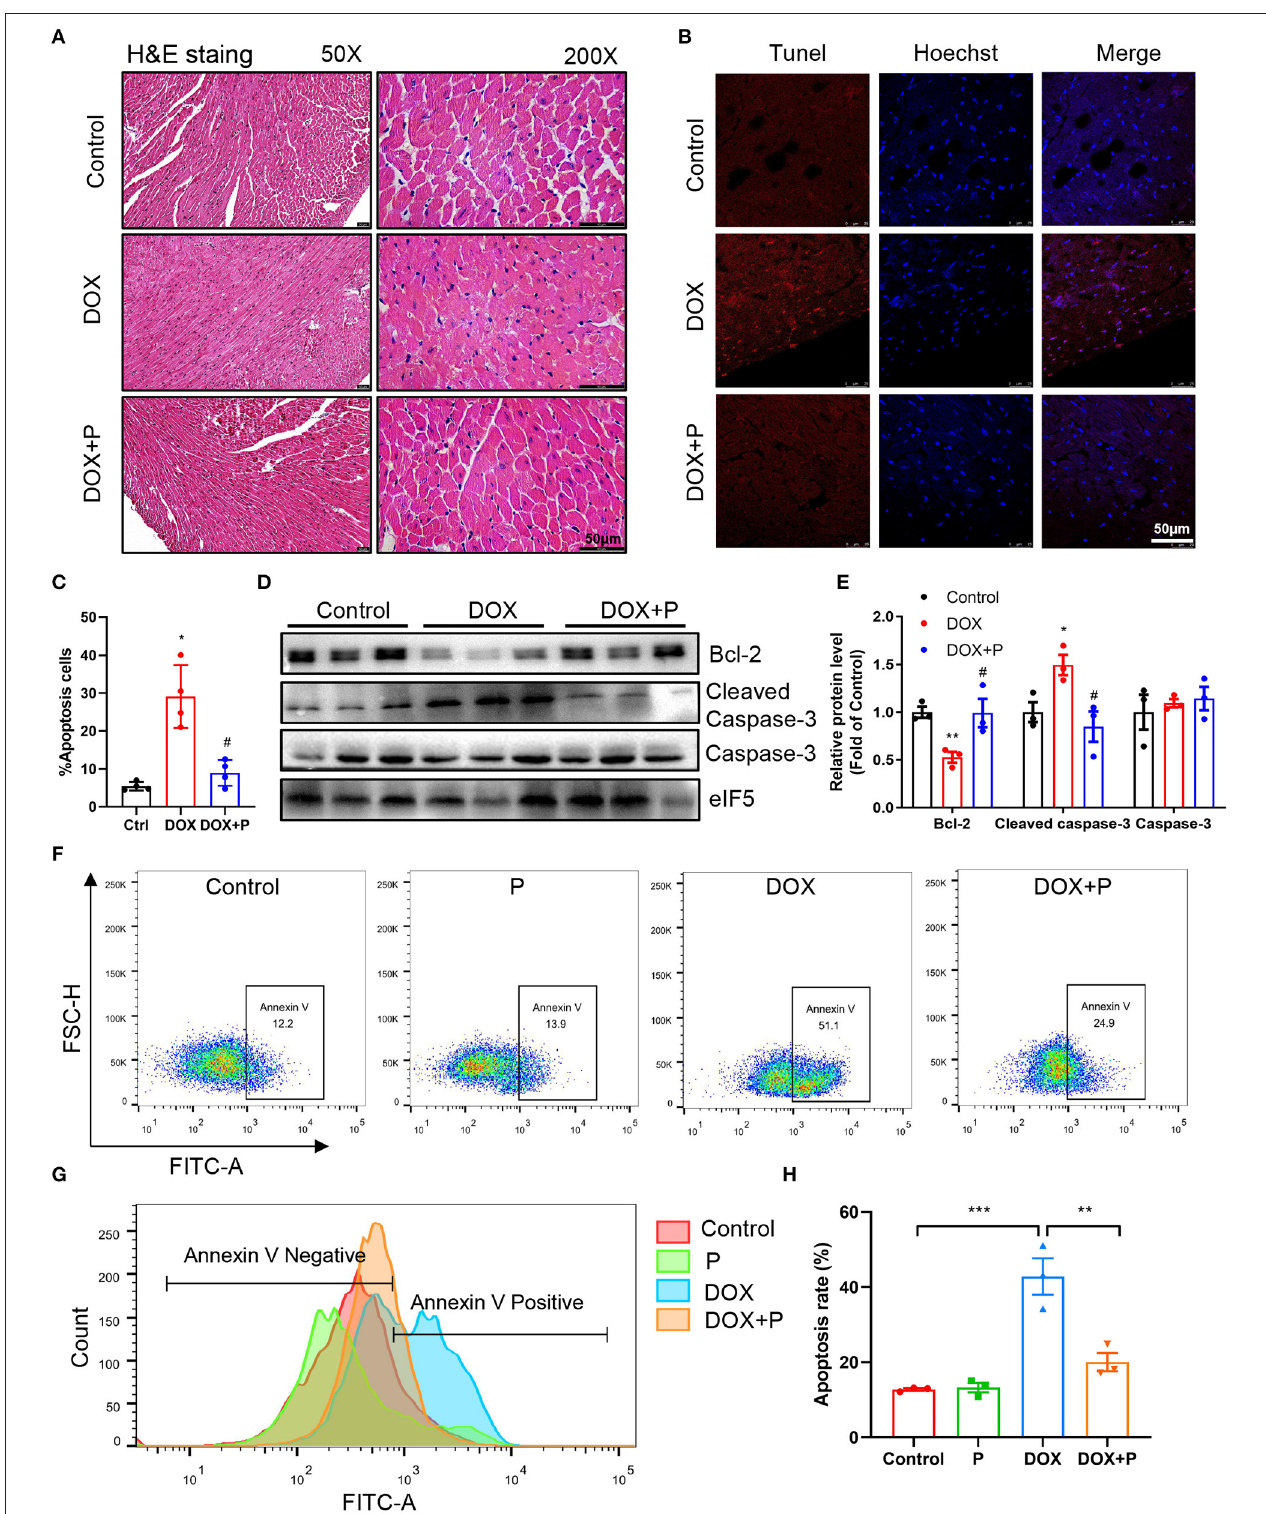
FIGURE 2 | Periplocymarin improved cardiomyocyte apoptosis induced by DOX. (A) Representative micrographs of hematoxylin and eosin (H&E) staining. The left panel is 50X (Scale bar, 50 µ m), the right panel is 200X (Scale bar, 50 µ m). (B,C) Representative fluorescent images of terminal deoxynucleotidyl transferase